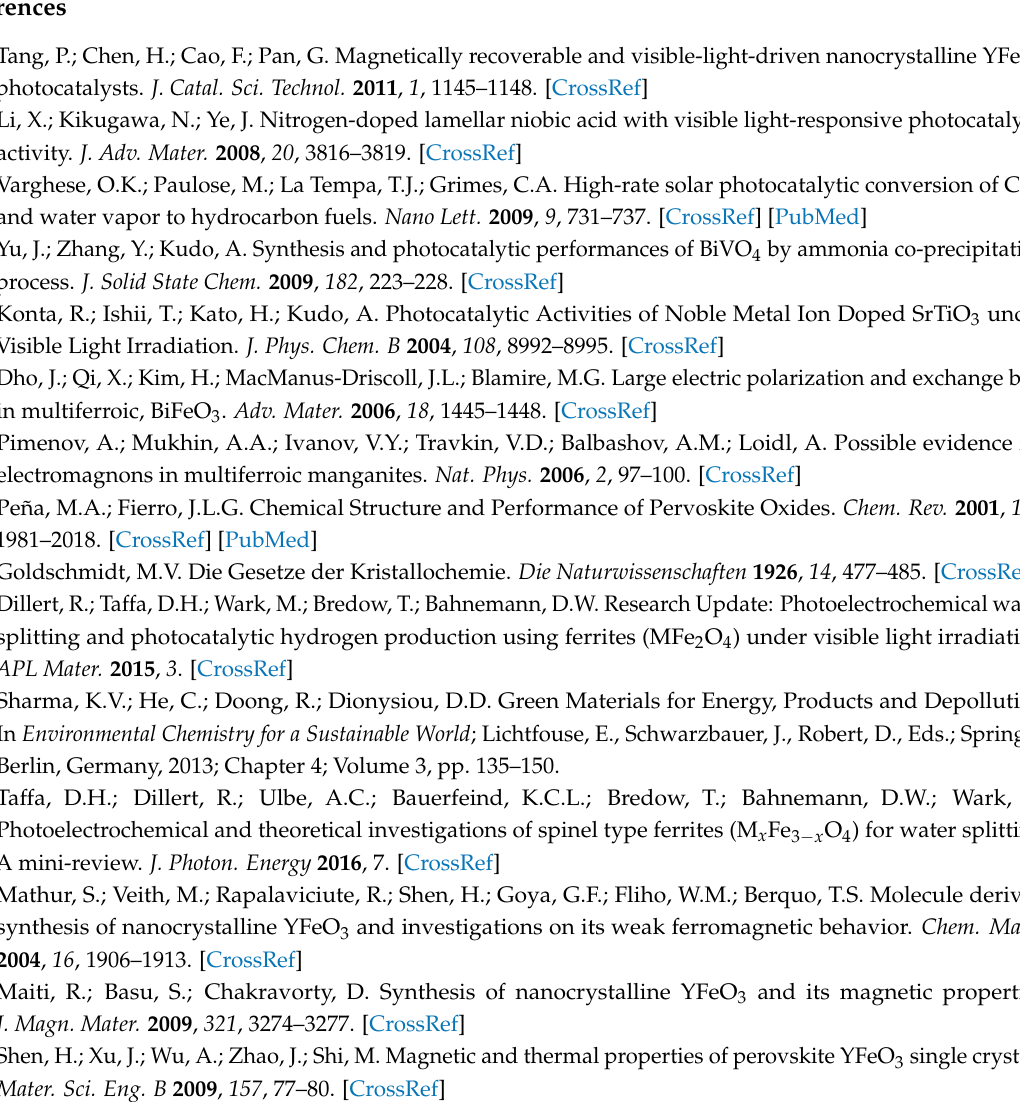
Figure S1: SEM micrographs of (a) hex-675 and (b) orth-900. (c) The EDXS analysis showing the elemental composition, Figure S2: Fluorescence spectral changes observed during visible light illumination of hex-675 sample in terephthalic acid (TA) solution (3 mM TA/10 mM NaOH M, excitation at 320 nm). The spectra were recorded at intervals of 1.5 h, Figure S3: Photocatalytic degradation curves for 4-CP (1 × 10 − 3 M) using hex-675. Light source: 150 W Xe arc lamp with cut-off filter λ > 420